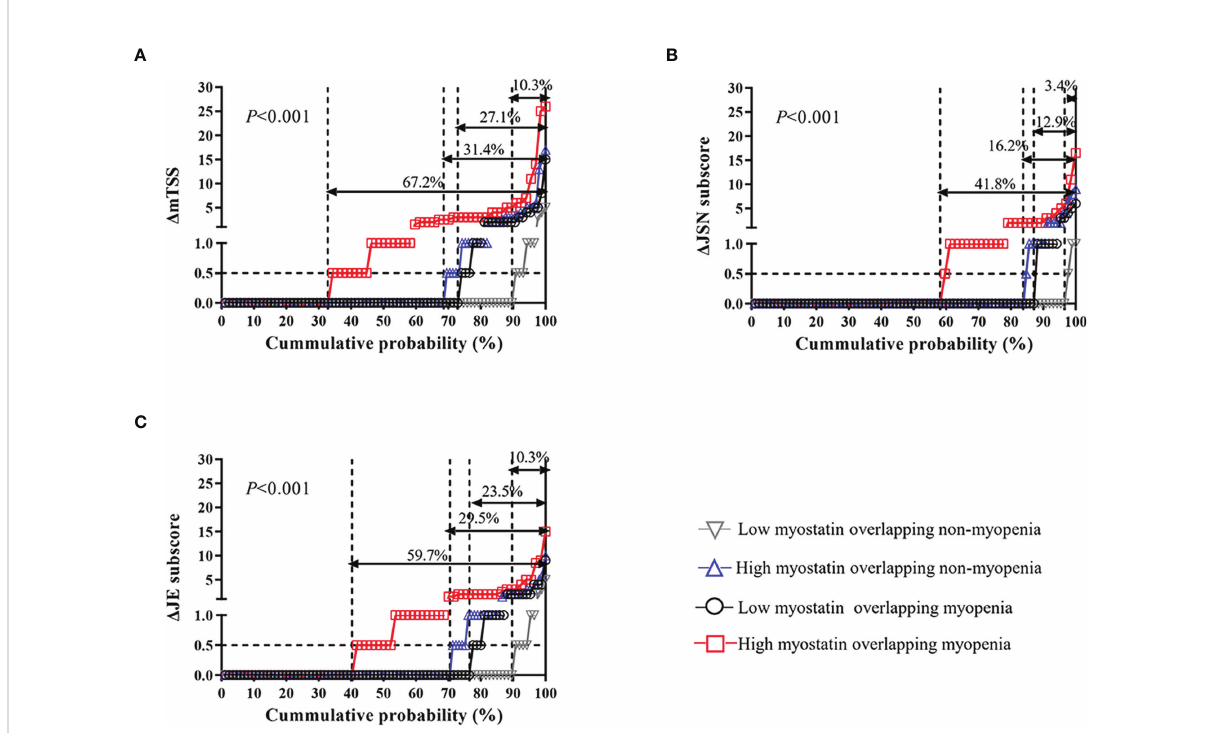
FIGURE 3 One-year radiographic progression among four RA subgroups by serum myostatin and myopenia at baseline. The cumulative probability distribution of radiographic change including mTSS (A) , JSN subscore (B) and JE subscore (C) from baseline to 12 months in RA patients among four subgroups. D mTSS, a change in mTSS from baseline to 12 months; D JSN subscore, a change in joint space narrowing subscore from baseline to 12 months; D JE subscore, a change in erosion subscore from baseline to 12